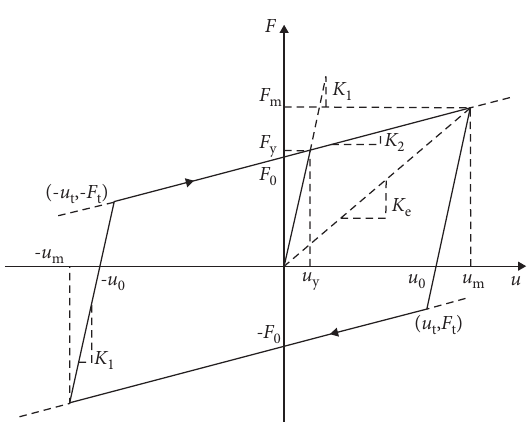
Figure 5: Bilinear mechanical model. K 1 : initial stiffness, K 2 : stiffness , F ): (yield displacement, yield after yield, K e : equivalent stiffness, ( u y y , F shear force), ( u ): (maximum displacement, shear force corre- m m sponding to the maximum displacement), F 0 : feature strength of the damper (shear force provided by the damper when the displacement is zero), u : feature displacement of the damper (displacement of the 0 ,F damper when the shear force is zero), ( u ): displacement of the t t yield point under reverse loading and corresponding shear